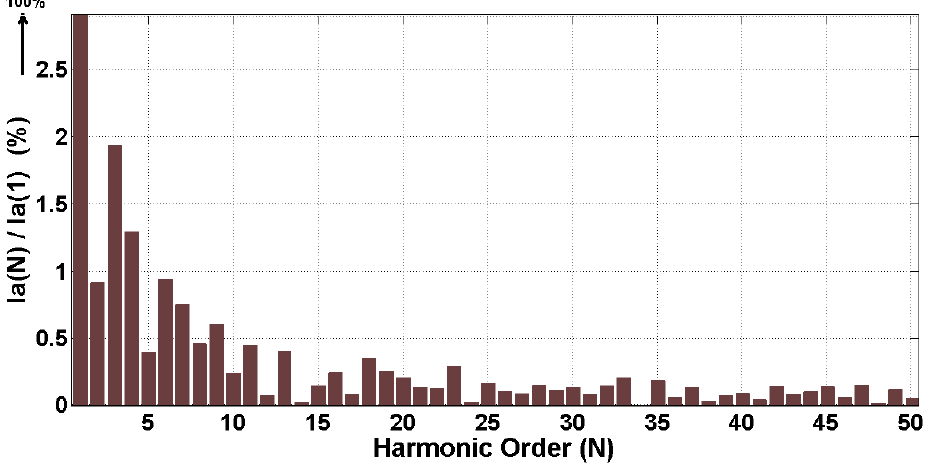
Figure 24. Low Harmonic content for line current i a for comparison with Standard EN 61000-3-2.